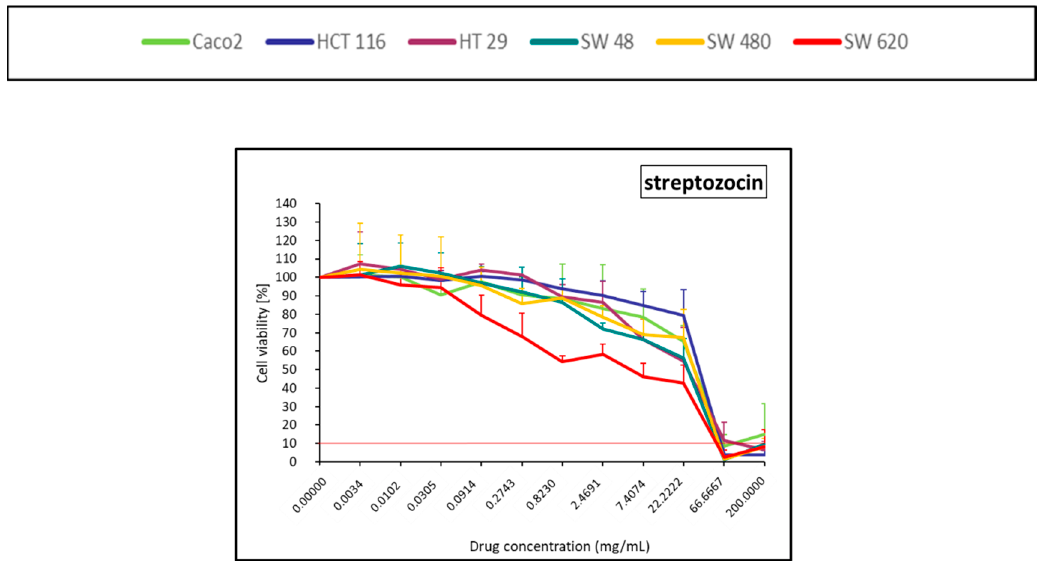
Figure 6. Colorectal cancer cell line viability curves (mean ± standard deviation) after a 30 min contact time with an antitumoral antibiotic (streptozocin). The horizontal red line represents 10% of cell viability. The results are presented after normalization with the control cells (untreated condition).